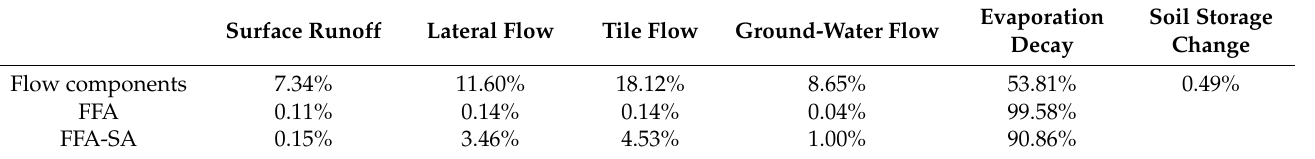
Table 5. Ratio of flow components, FFA and FFA-SA within the different flow components for the LR-FS